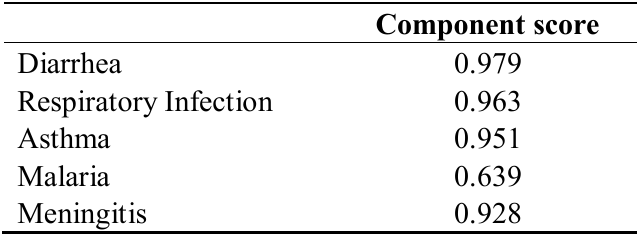
Table 4. Communalities explained by each